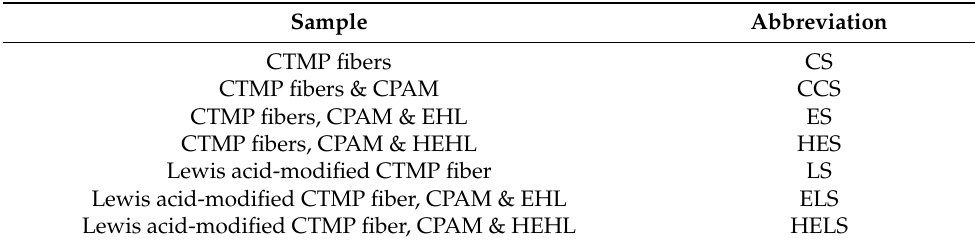
Table 1. Names given to the control group